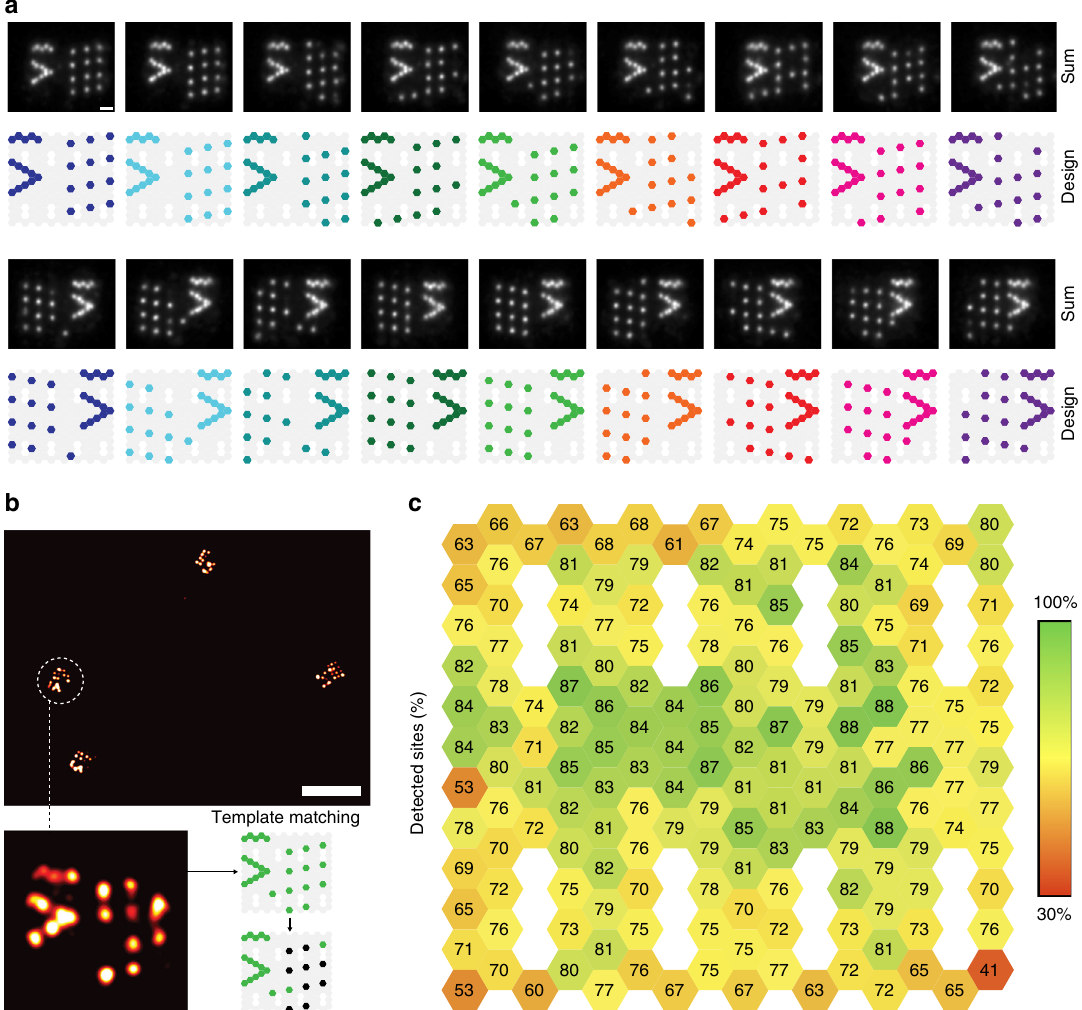
Fig. 15) of thermal fl uctuation of the same rectangular origami